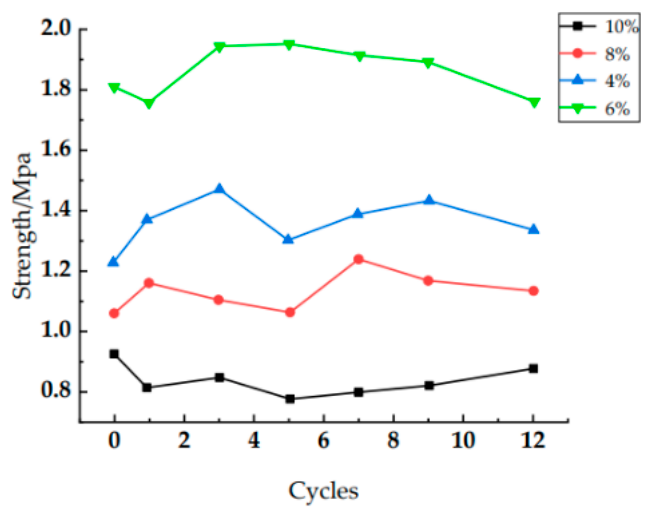
Figure 5. Positioning shift strength of different numbers of dry–wet cycles.